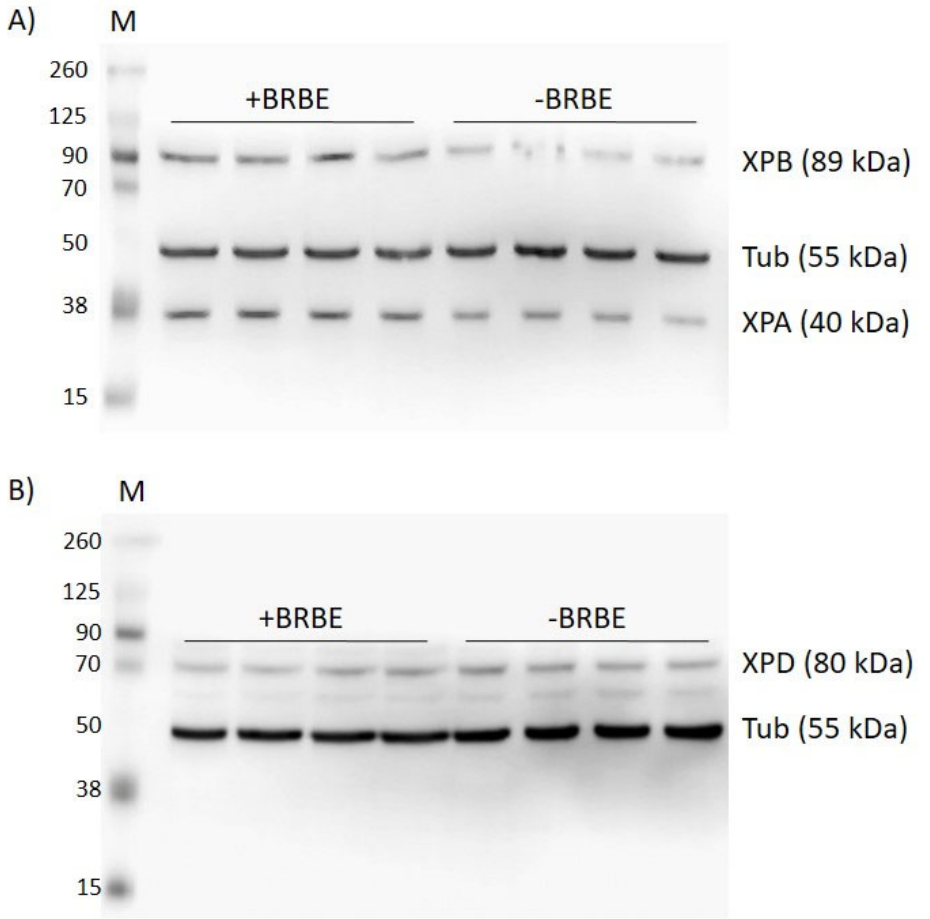
Figure 7. Enhancement of NER protein expression in BRBE-treated HeLa cells. ( A ) XPA, XPB and ( B ) XPD protein expression in HeLa cells, all with and without pre-treatment with BRBE. Tubulin is an inert cellular protein that was used as a control for the overall cellular protein concentrations in BRBE-treated and untreated cells. All Western Blot measurements of relative protein concentrations were conducted within the linear range of overall protein concentrations shown in Figure 8.